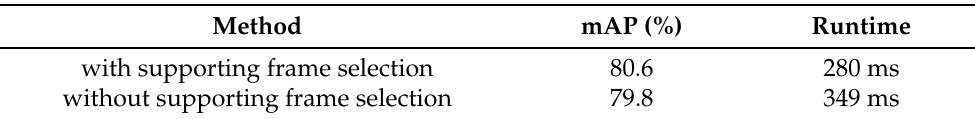
Table 5. Performance comparison and time consumption with/without supporting frame selection. (max 300 ROIs per frame).